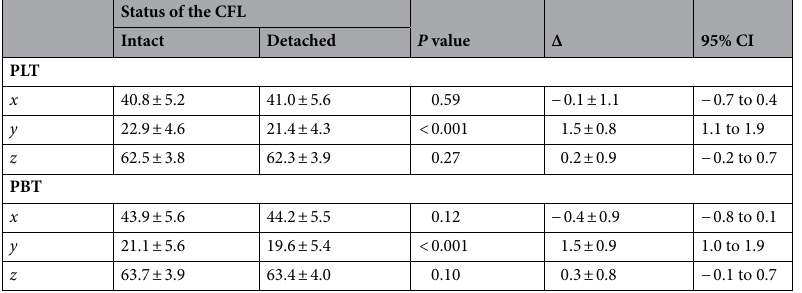
Table 1. Changes in the mean positional coordinate of the peroneal tendons in the presence or absence of the CFL. The values are presented as the mean ± the standard deviation (mm). The difference (Δ) is calculated by subtracting the position when the calcaneofibular ligament (CFL) is detached from the position when the CFL is intact. CI confidence interval, PLT peroneus longus tendon, PBT peroneus brevis tendon.